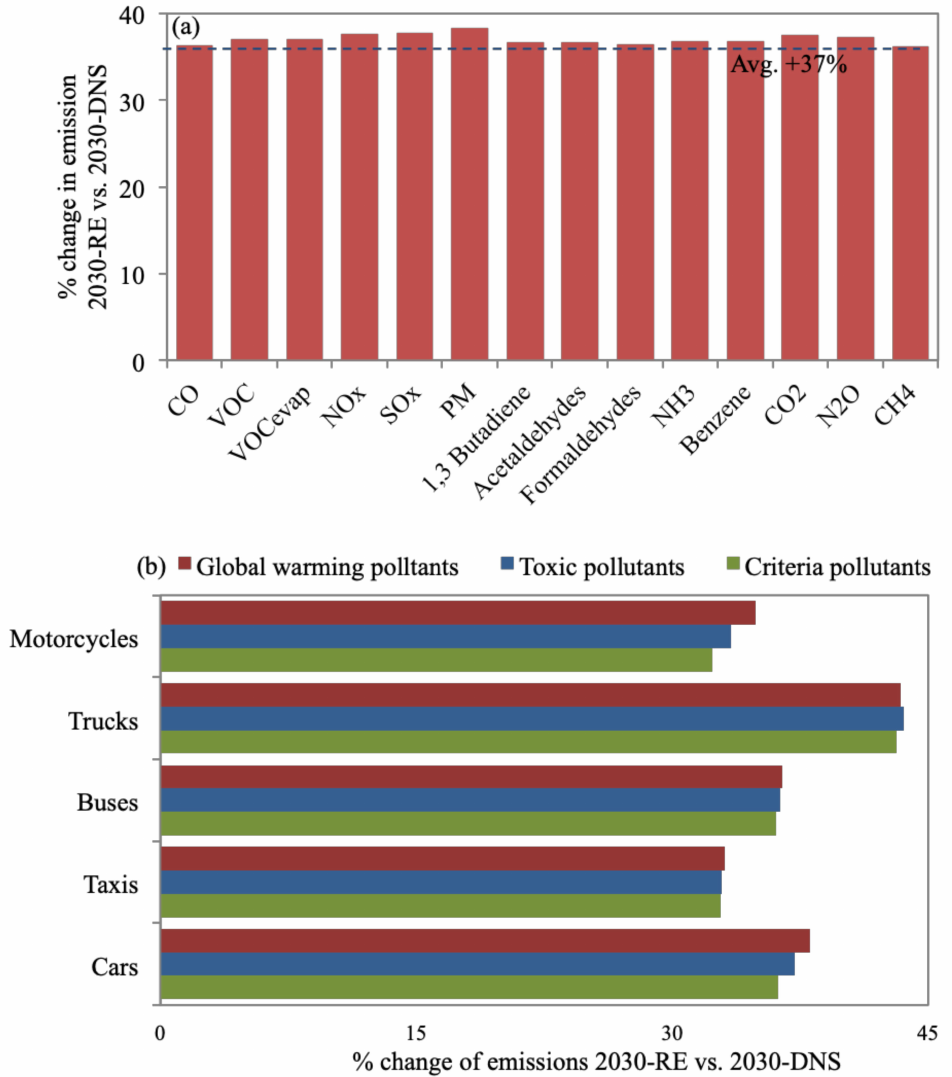
Figure 5. Percent change of ( a ) all daily emission types for 2030-RE in reference to 2030-DNS, while ( b ) provides a breakdown of reduction of each pollutant group for each vehicle